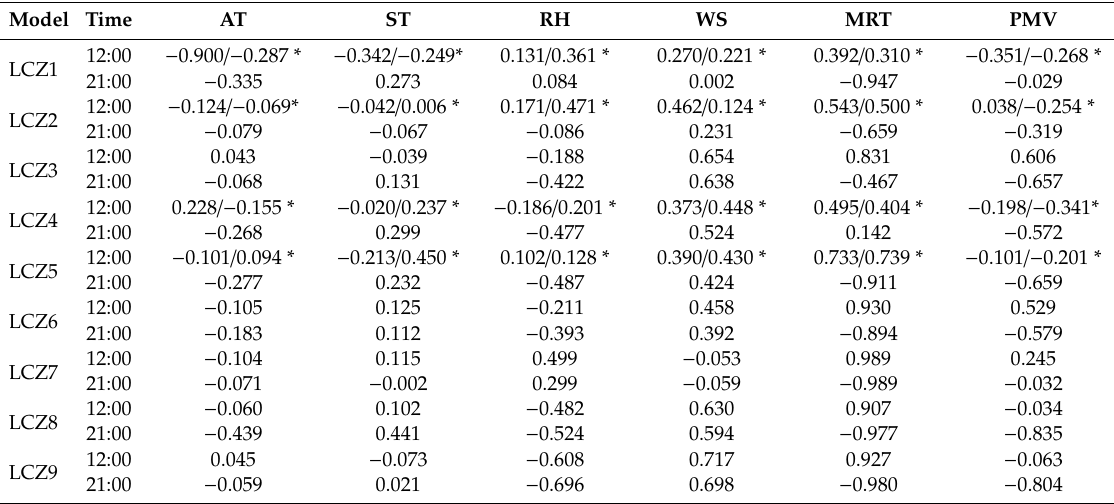
Table 3. Correlation coefficients R between SVF and the microclimate/thermal comfort indices for all the nine models. Please note that, when two values are present, * refers to the shadow area.